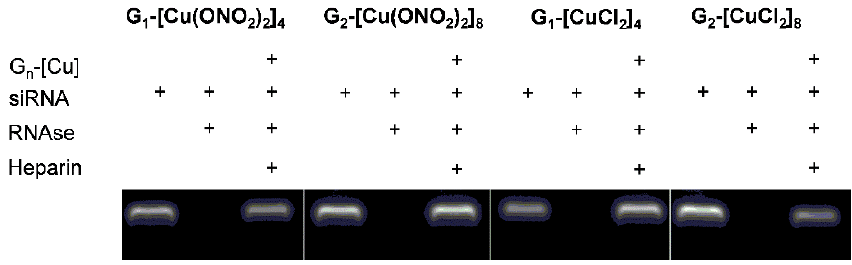
Figure 3. Protective effect of G n -[Cu(X) 2 ] m (X = Cl or ONO 2 ) to siRNA against degradation by RNase. [siRNA]= 2 μM, [RNase A] =3.0 μg /mL for 30 min at 37°C, [heparin] = 0.082 mg/mL.